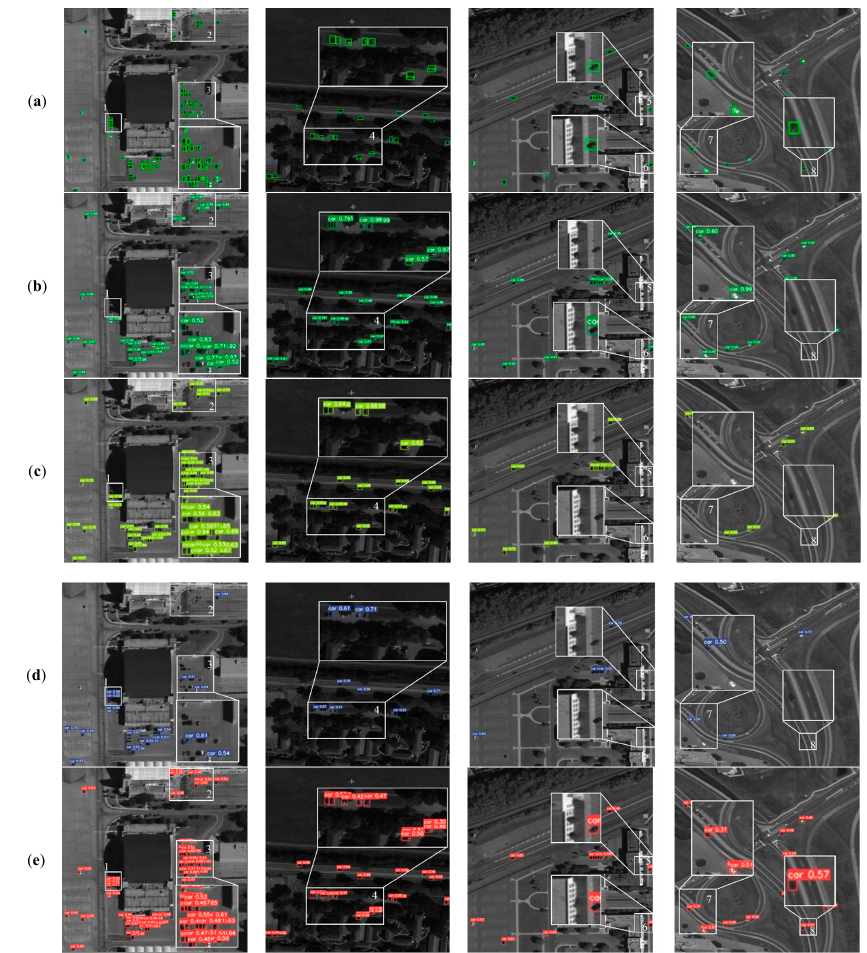
Figure 9. Visualization of the detection results for different methods. ( a ) Input images with ground truth, ( b ) Cascade-RCNN, ( c ) imYOLOv3, ( d )FII-CenterNet, and ( e ) our